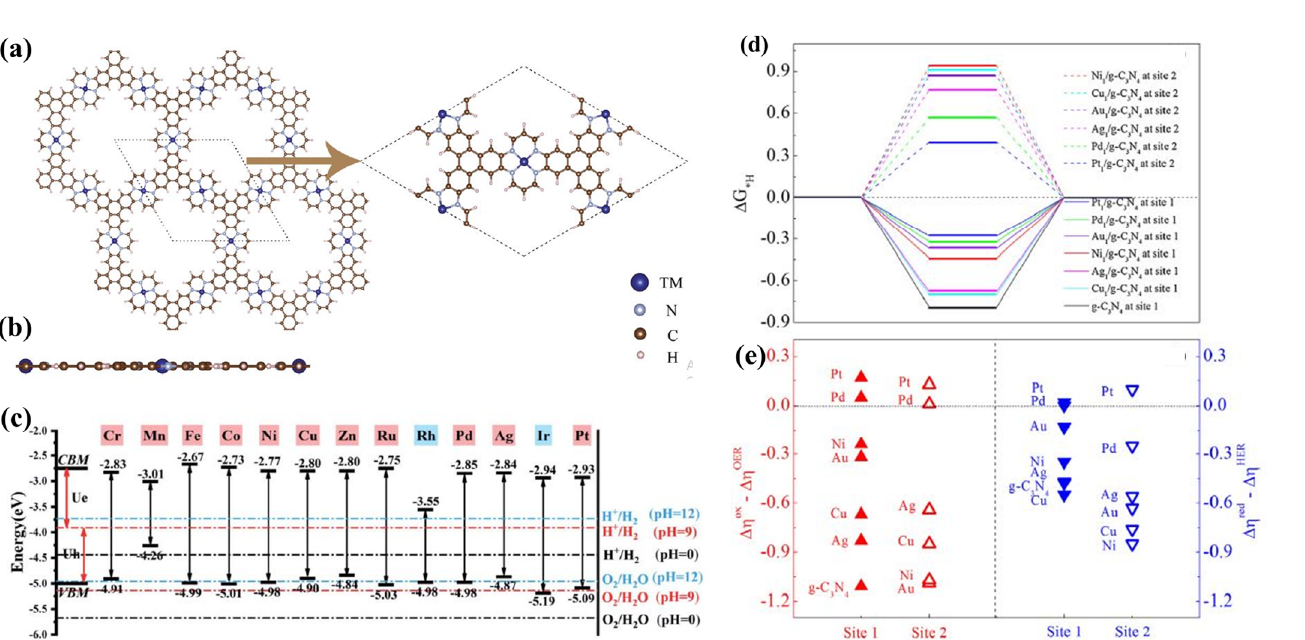
Figure 6. ( a ) Top and ( b ) side views of the planar TM-TAA MOF monolayers. The rhombus primitive cell of the 2D MOFs is also shown. ( c ) Electron energies of various TM-TAA MOFs. The vertical bars show the bandgap. The vacuum level has corrected the energy level positions. Reprinted with permission from ref. [128]. Copyright 2021 RSC. ( d ) The relationships of the calculated overpotentials (Δη OER and Δη HER ) with the differences between the redox potentials of specimens and water oxidation/H+ reduction (Δη ox and Δη red ). ( e ) The free energy charges of HER at sites 1 and 2 of specimens. Reprinted with permission from ref. [104]. Copyright 2018 Elsevier.